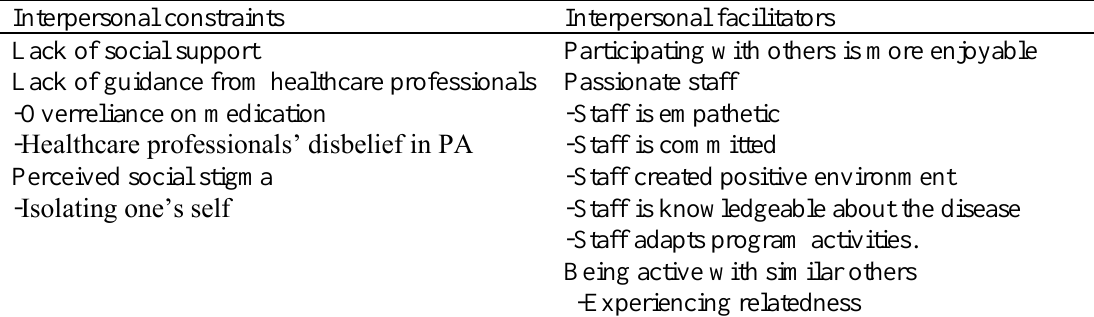
Table 3. Interpersonal factors influencing PA behaviour for individuals with PD Interpersonal